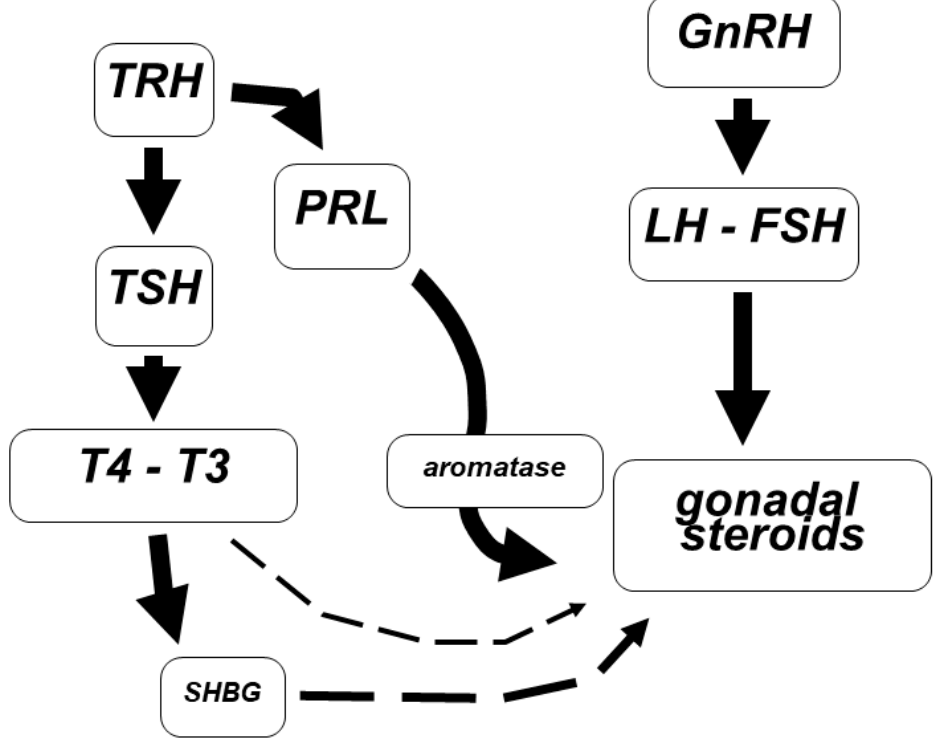
Figure 2. Schematic representation of the interconnection between PRL and thyroid axes. TRH is able to induce both PRL and T4 secretion. Whatever event reduces or increases TRH release leads to a change in the concentrations of SHBG as well as in the expression of aromatase, so as to impair the gonadal steroids synthesis and binding.